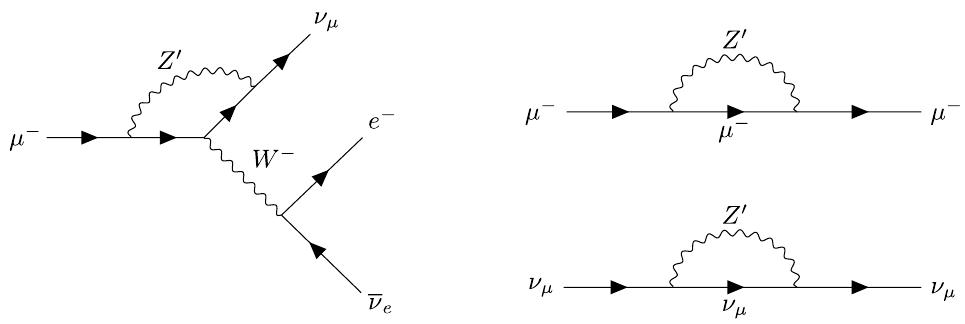
Figure 3. The Z 0 -induced vertex and self-energy corrections contributing to the ∆ r parameter. There are no contributions from similar diagrams but with the flavon Goldstone replacing the Z 0 in the loop because the U (1) B symmetry is vectorial and does not come with a Yukawa sector. 3 − L 2